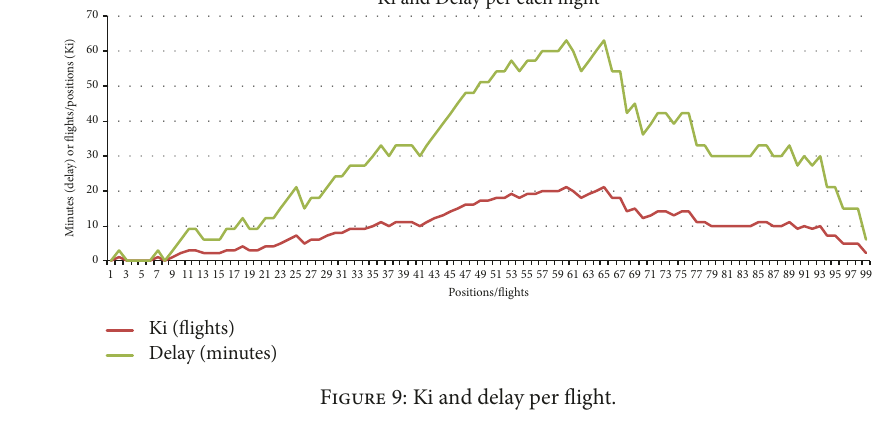
Figure 9: Ki and delay per flight.